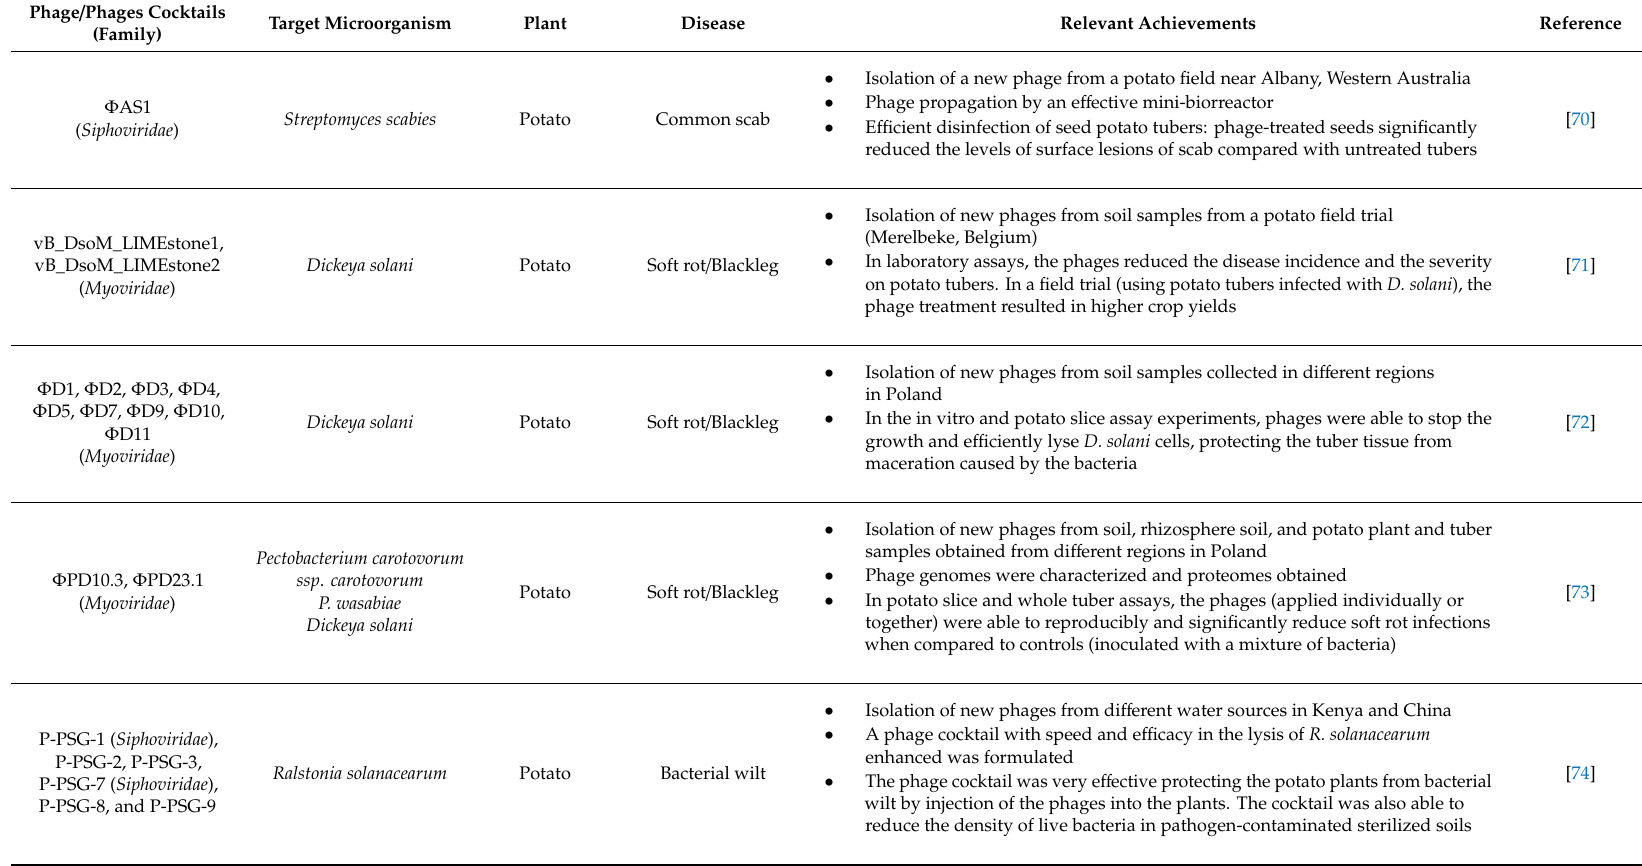
Table 1. Relevant examples of phages used in the biocontrol of plant